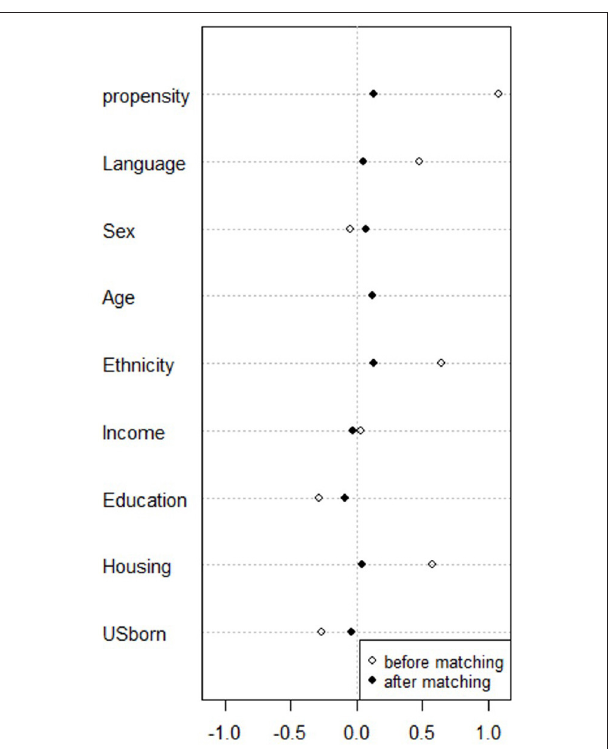
FIGURE 2 | Dotplot of standardized mean differences (Cohen’s d) for all covariates before and after matching survey participants in Granger, WA and Wilder, ID ( N =